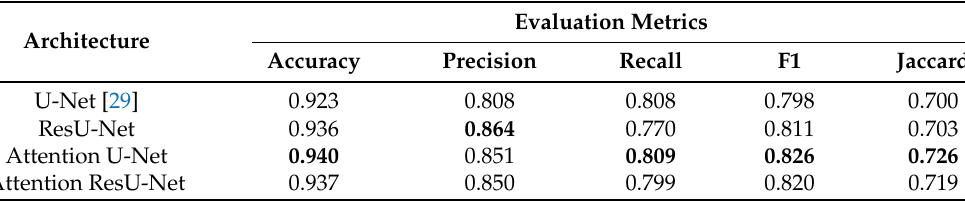
Table 1. Comparison of the performance between U-Net architectures. Best scores are annotated in bold.